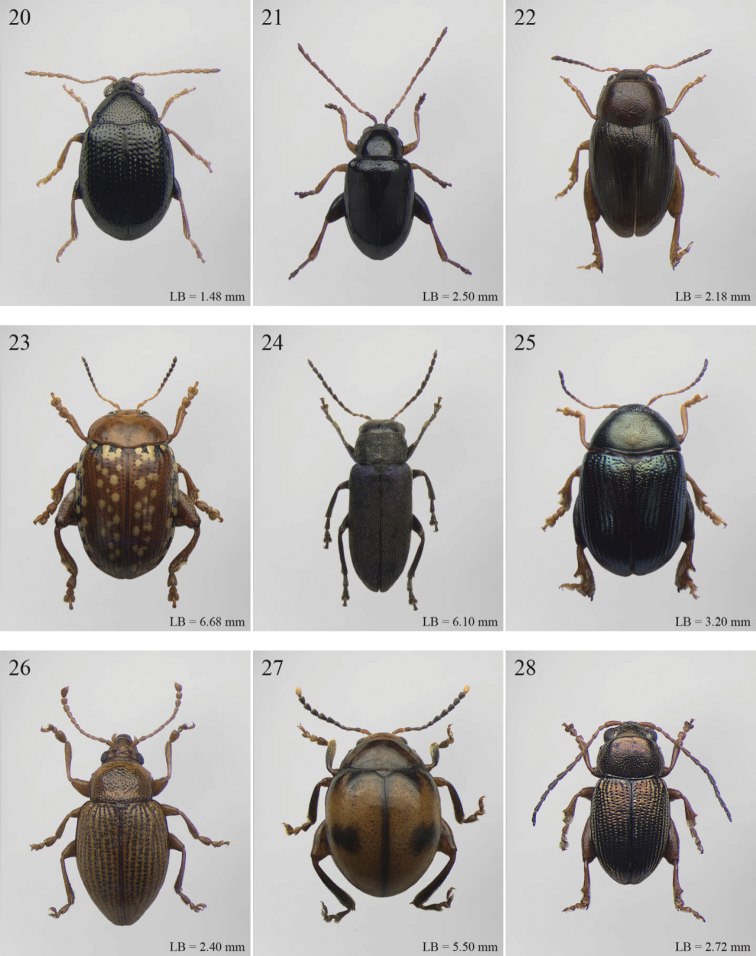
Habitus. 20
Bezdekaltica socotrana Döberl 21
Bikasha tenuipunctata Maulik 22
Biodontocnema brunnea Biondi 23
Blepharida ornata Baly 24
Buphonella nigroviolacea (Allard) (genus transferred to Galerucini) 25
Carcharodis rugiceps (Baly). 26
Celisaltica ruwenzorica Biondi 27
Chabria bezanozana Biondi & D’Alessandro 28
Chaetocnema purpurea Jacoby.